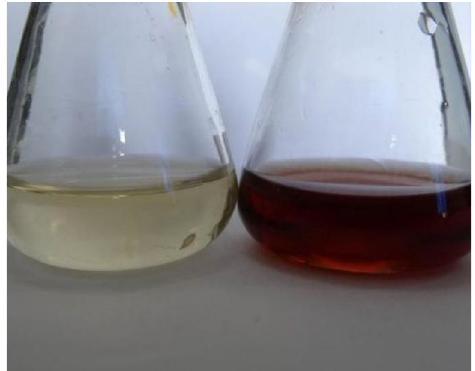
Figure 3. The cell filtrate of Aspergillus sydowii without AgNO 3 (left) and with AgNO 3 .